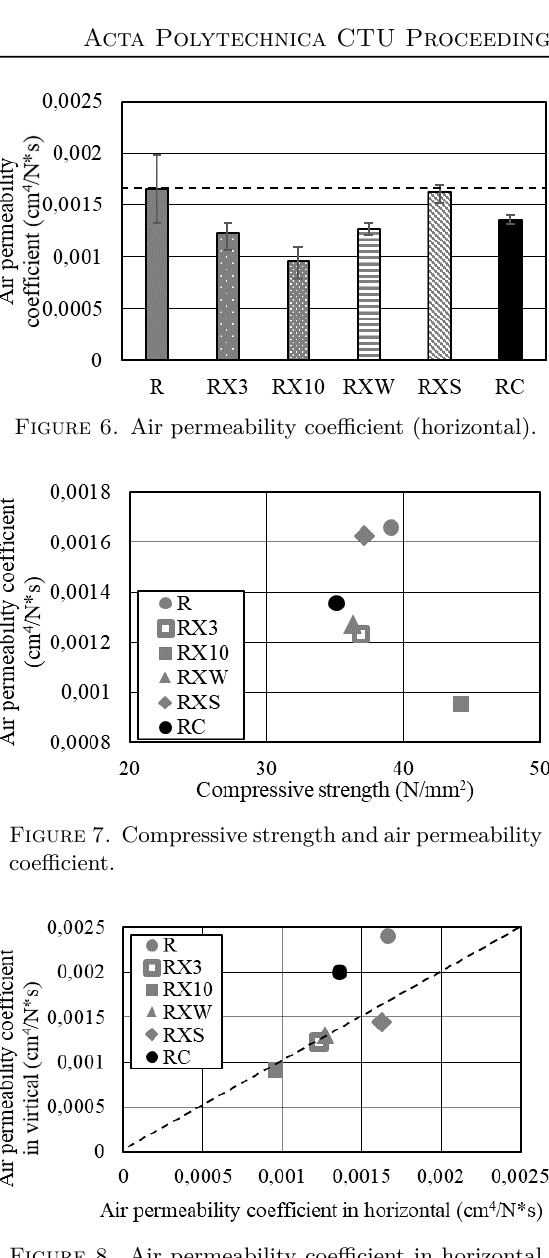
Figure 8. Air permeability coe ffi cient in horizontal and vertical